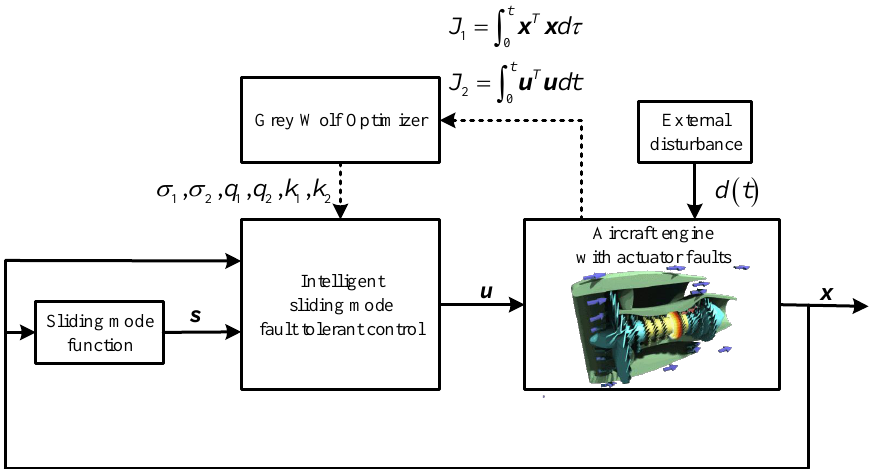
Figure 4. The block diagram of intelligent sliding mode fault-tolerant control method for aircraft engine.